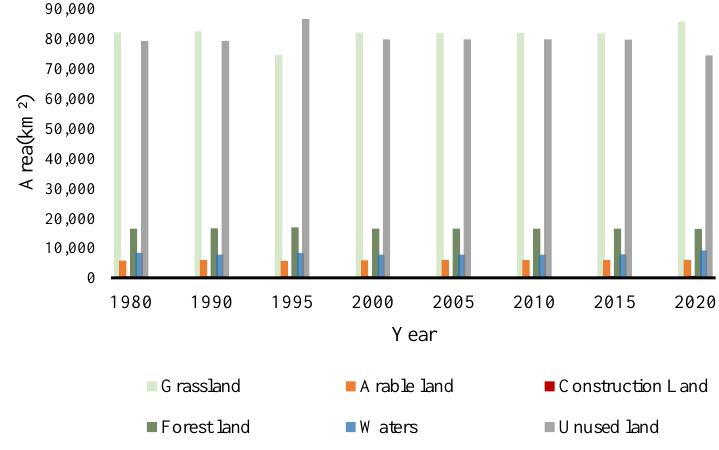
Figure 3. Area of land-use types in the Qilian Mountains.